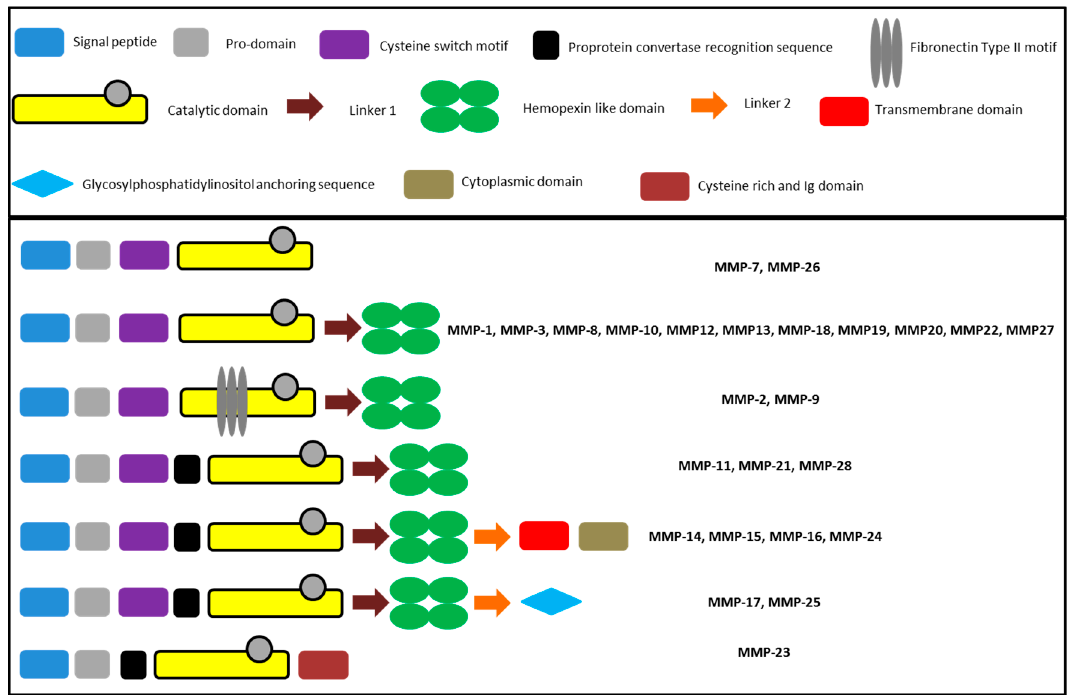
Figure 3. Composition of MMPs according to Nagase et al. [43].